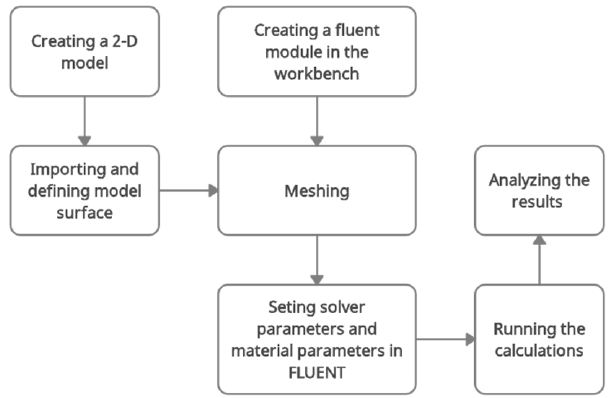
Figure 2. Simulation flow chart. After the 2D model of atomisation chamber is created by using SpaceClaim, the surface model is then meshed, as shown in Figure